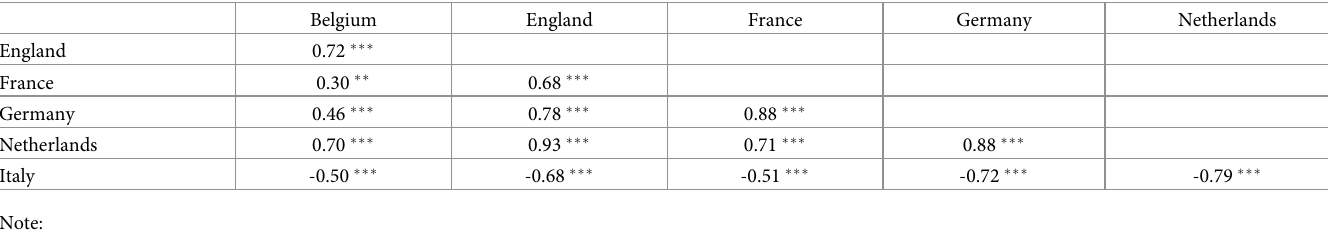
Table 1. Pairwise correlations annual seasonal